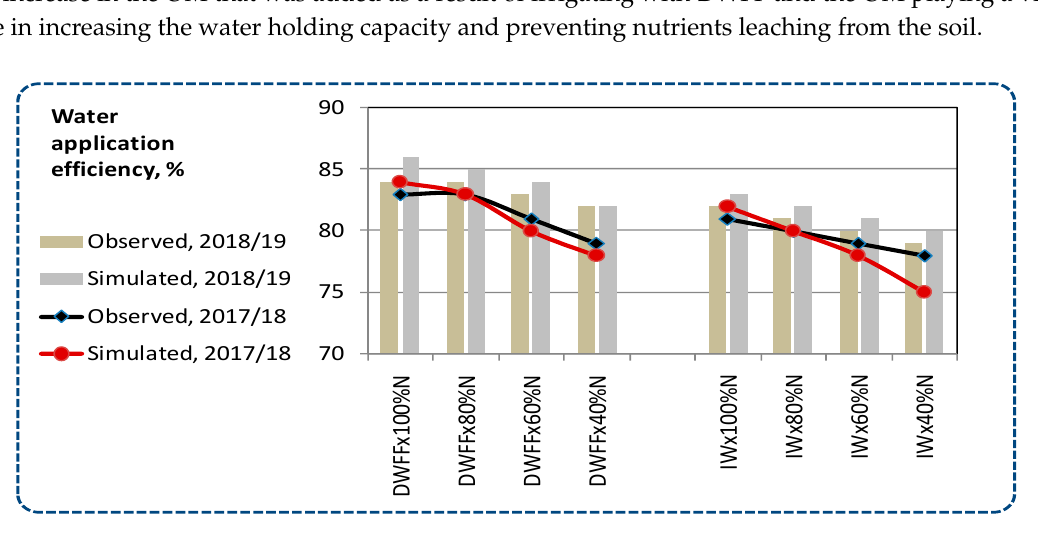
Figure 7. Effect of water quality and fertigation rate of nitrogen on the water application efficiency (WA E ) at the peak of irrigation during growing seasons and compared with simulated WA E for all treatments for the 2017/2018 and 2018/2019 growing seasons for different treatments: drainage water from fish farms (DWFF), fresh irrigation water (IW), and nitrogen (N).